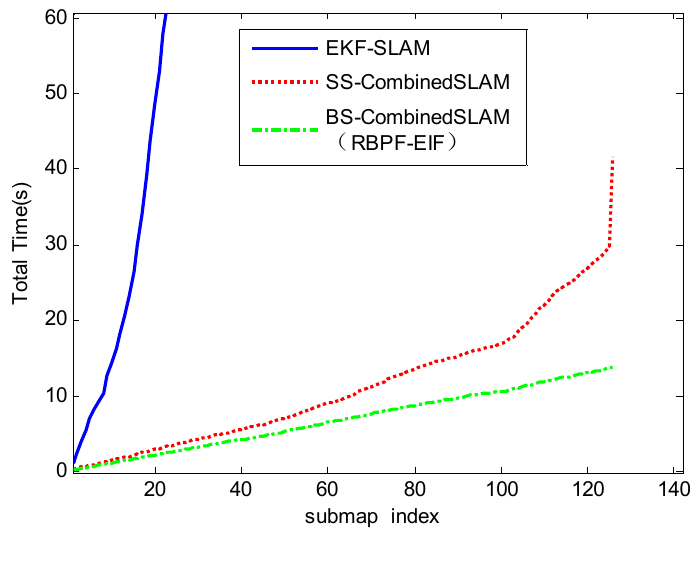
Figure 9. The computation time for three algorithms: conventional single-map-type EKF-SLAM (blue), sequential submap-type Combined SLAM (red) and binary-tree-based submap-type Combined SLAM